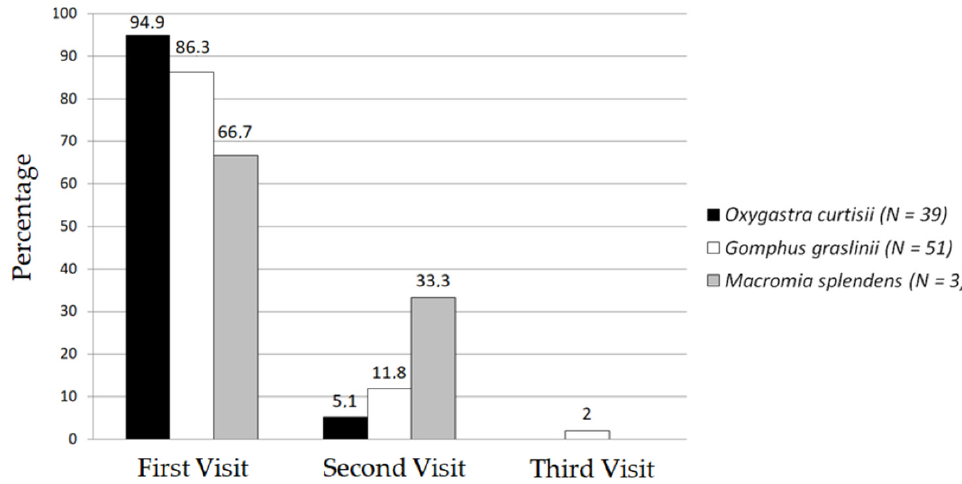
Figure 6. Distribution of the first detection for the three species of community interest, Gomphus graslinii , Macromia splendens , and Oxygastra curtisii , across the first, second, and third visits.